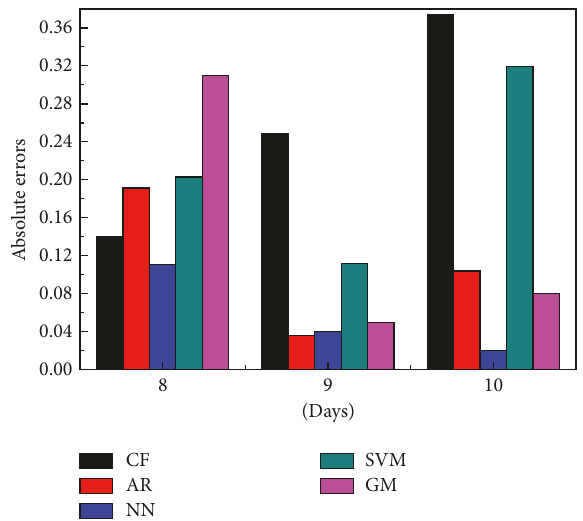
Figure 4: The absolute error between the actual and predicted values for the second